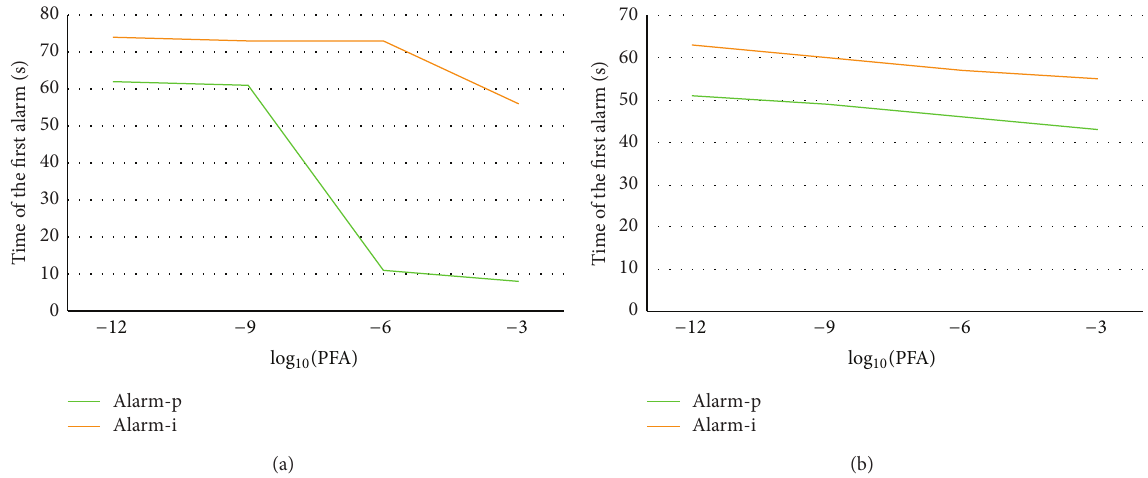
Figure 11: Time of the first alarm versus PFA for persistence (Alarm-p) and increasing (Alarm-i) alarms, in Font Roja (a) and Ayora (b).